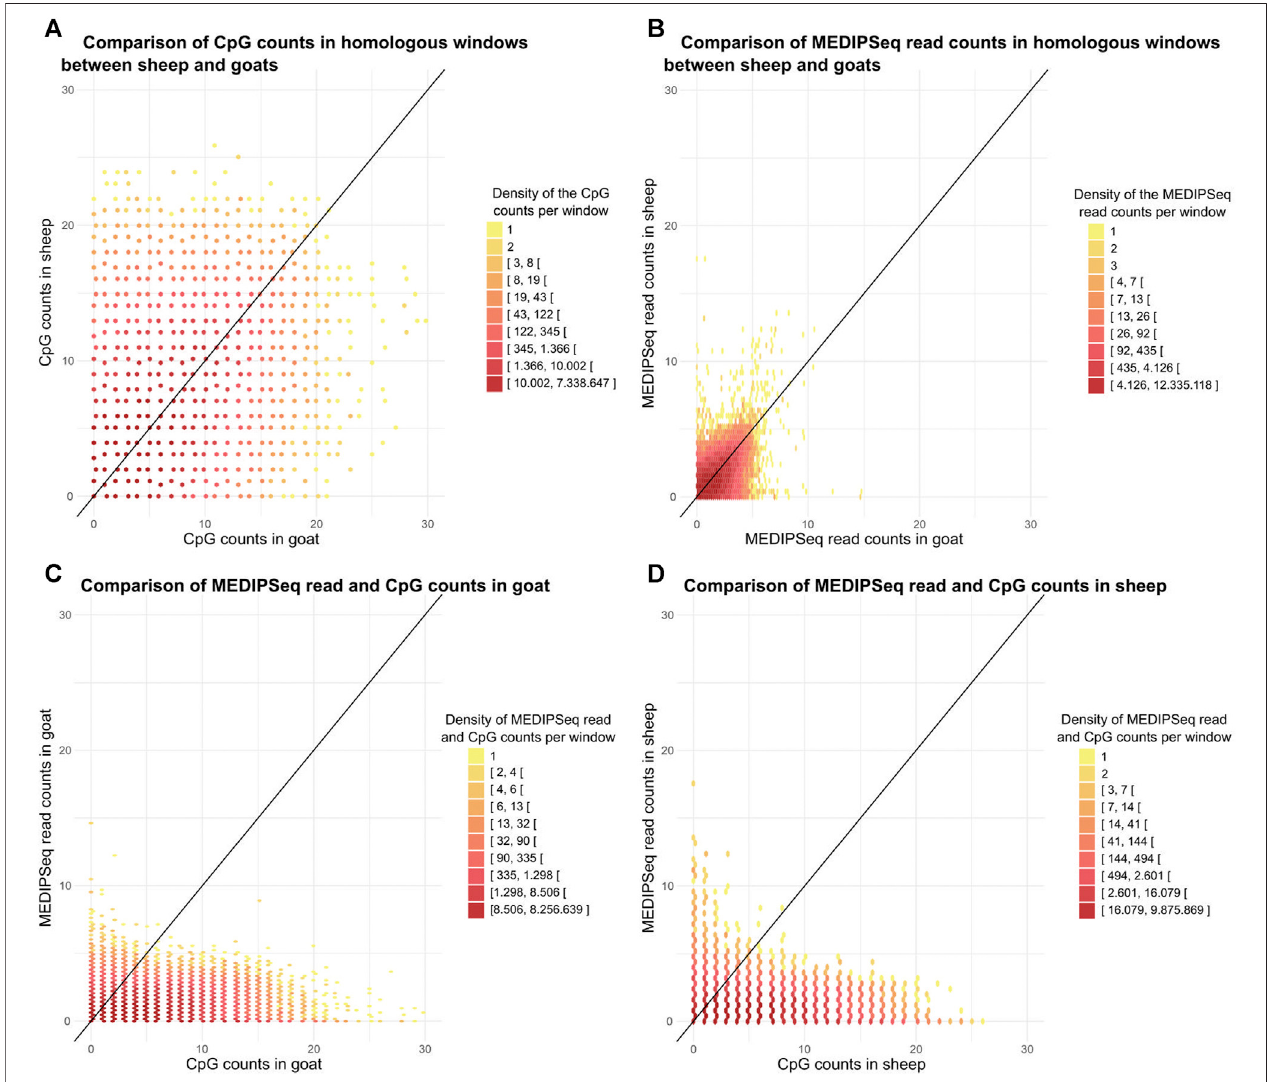
FIGURE3| Characterizationandcomparisonofsheepandgoatsmethylomes.Relationshipbetweenthenumberof (A) .CpG,or (B) .MeDIP-Seqreadsper100bp window between the two species across the genome. Relation between the number of MeDIP-Seq reads and the number of CpG per 100 bp widow for (C) . goat, and (D) . sheep. The colors represent the number of points and the black line (y (cid:1) x) is represented.